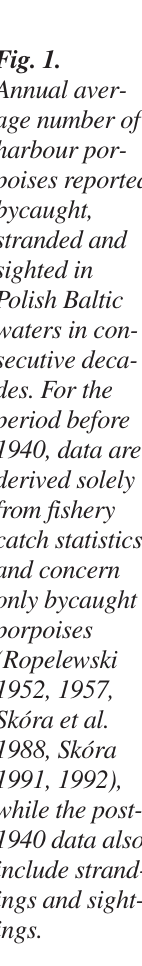
Fig. 1. harbour por- poises